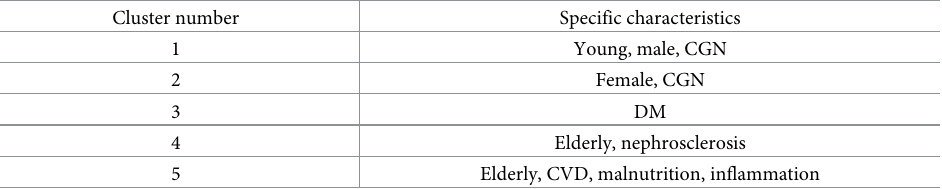
Table 6. Specific characteristics of clusters.